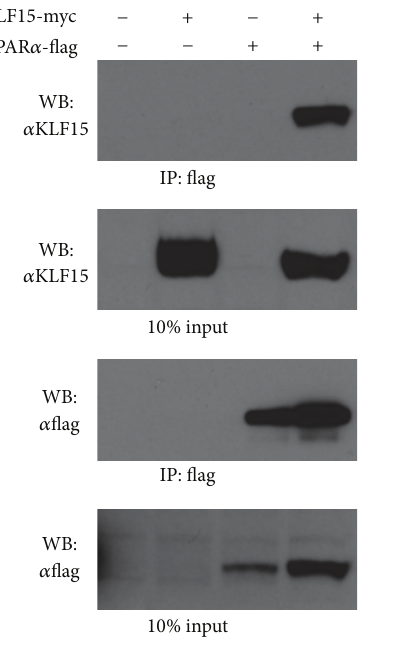
Figure 2: KLF15 and PPAR 𝛼 direct interaction. Co-IP demonstrat- ing protein-protein interaction between overexpressed KLF15 (Myc- tagged) and PPAR 𝛼 (Flag-tagged) in nuclear extracts of NIH-3T3 cells. Immunoblots presented are from a representative experiment that has been repeated three times.